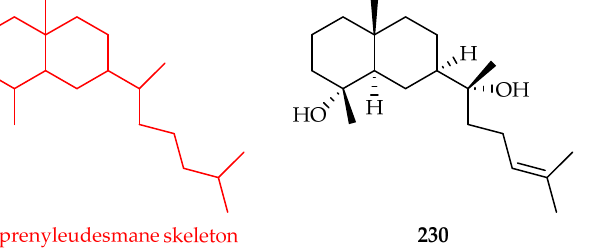
Figure 90. Structures of prenyleudesmane skeleton and lonimacranthoidin C 230